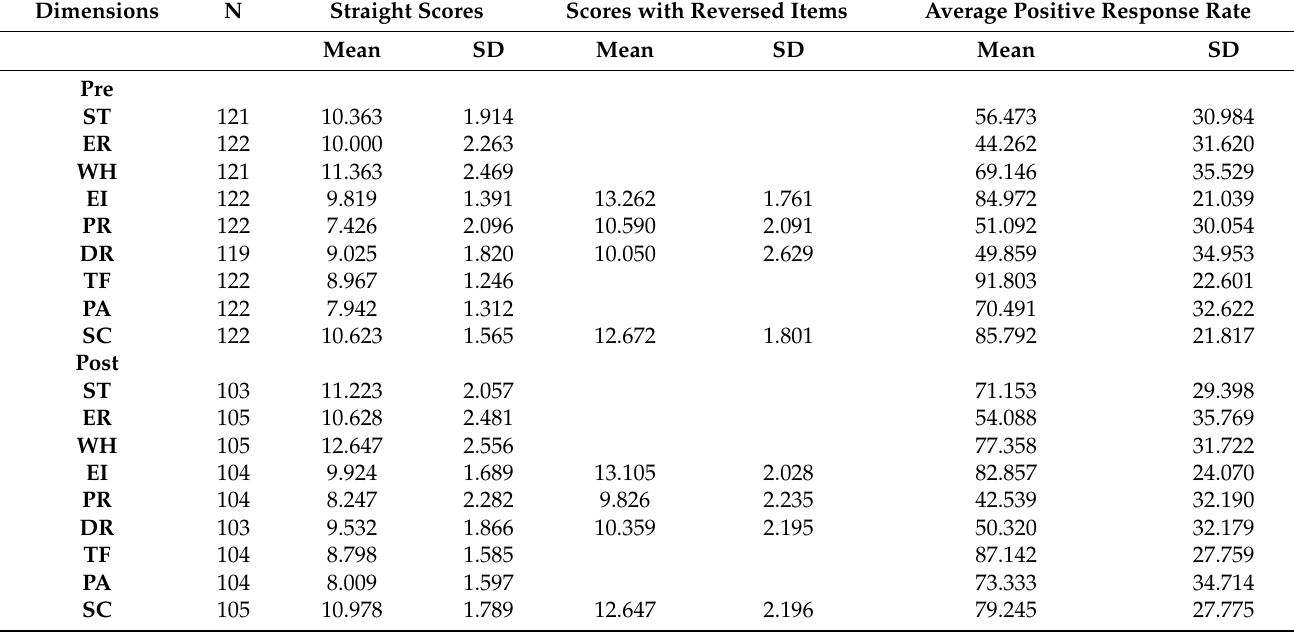
Table 2. Descriptive statistics of APSQ-III dimensions and average positive response rate per APSQ-III dimension at pre- and